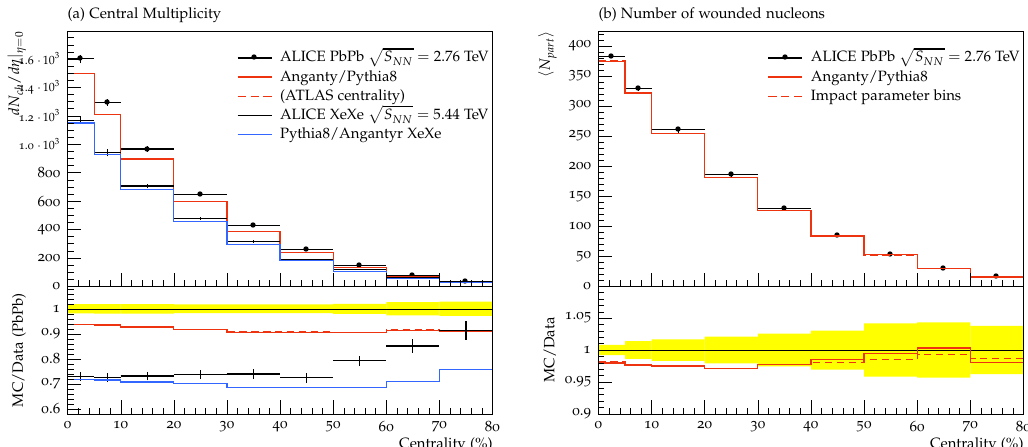
Figure 16 . (a) The centrality dependence of the average charged multiplicity in the central pseudo- rapidity bin for PbPb collisions at p s = 2 : 76 TeV and XeXe collisions at p s = 5 : 44 TeV. NN NN Data points (for PbPb) are from ALICE [53], while red (PbPb) and blue (XeXe) lines are from Angantyr. (b) Shows the averaged number of wounded nucleons as a function of centrality. The points are from a Glauber-model calculations from ALICE [53], while the red line is the result from Angantyr. For comparison the dashed line shows the number of wounded nucleons as a function of percentiles in generated impact parameter in